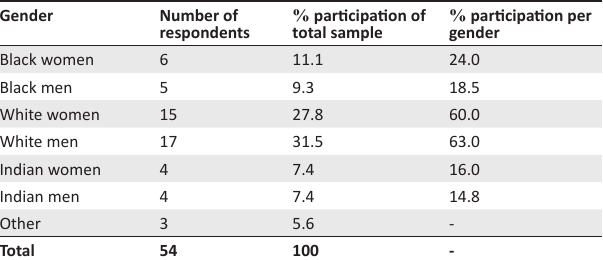
TABLE 1: A demographical distribution of respondents based on race and